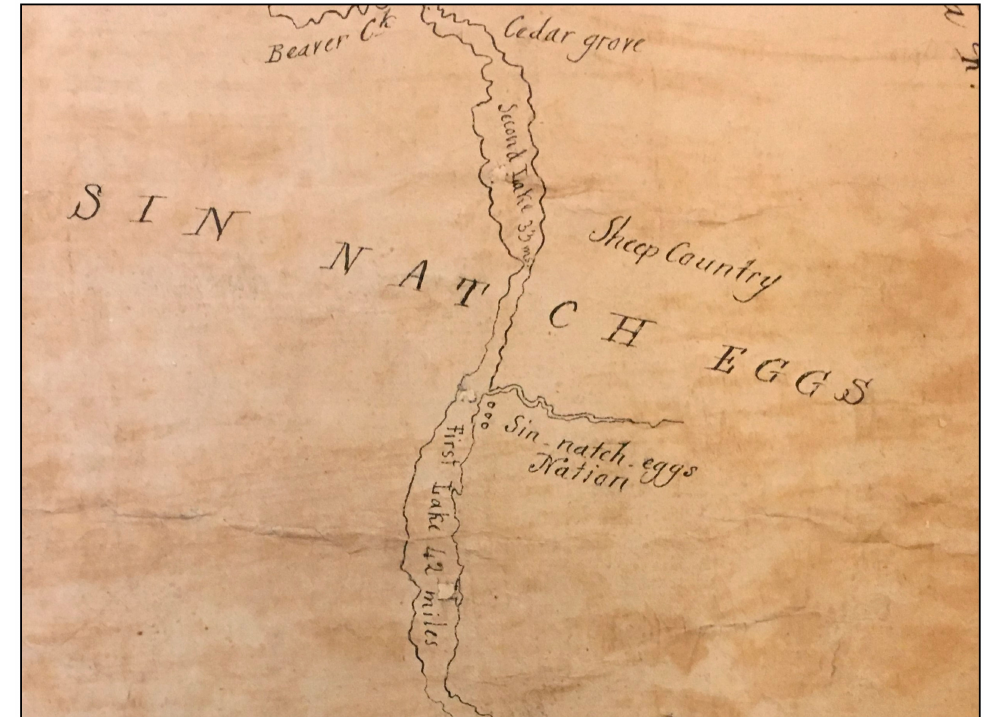
Figure 5. Detail from Ross, 1821. “Sin Natch Eggs” was Ross’s spelling for “Sinixt.” He placed the “Sin-natch-eggs Nation” on the Columbia River in the area of what are called today Upper and Lower Arrow